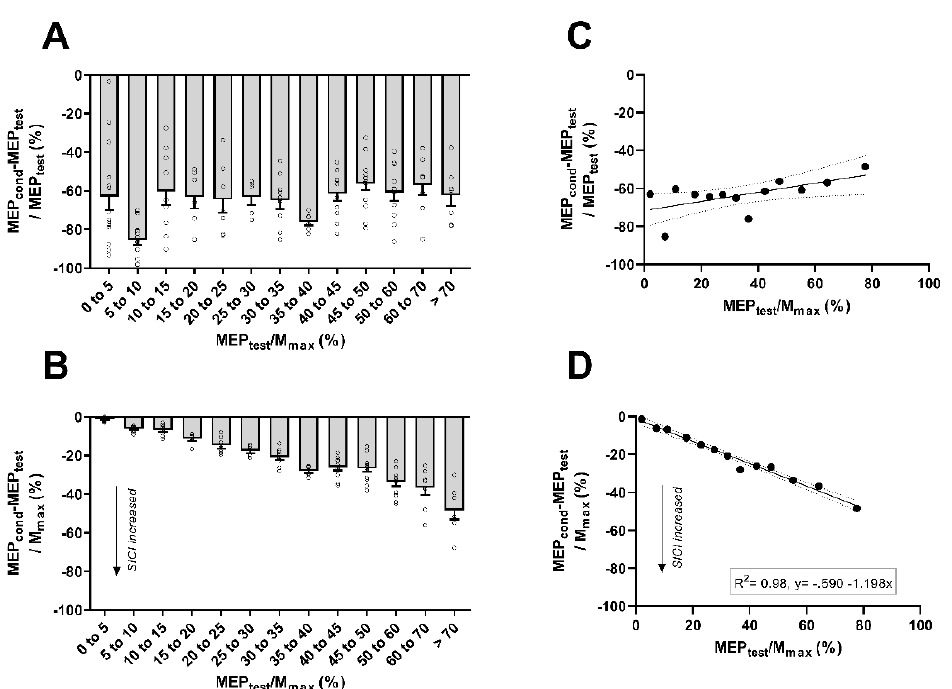
Figure 5. SICI normalized to MEP test (SICI MEPtest ) ( A ) and SICI normalized to Mmax (SICI Mmax ) ( B ) organized into di ff erent bins based on the MEP test / Mmax ratio. Grey bars represent the mean value for each bin, with standard error of the mean. Black dots represent individual values included in each bin. Non-significant regression plots between MEP test / Mmax ratio SICI MEPtest ( C ) and significant regression plots between MEP test / Mmax ratio SICI Mmax ( D ) Black dots in regressions represent the mean value for each bin. Grey lines in the regression figures represent 95% confident interval.